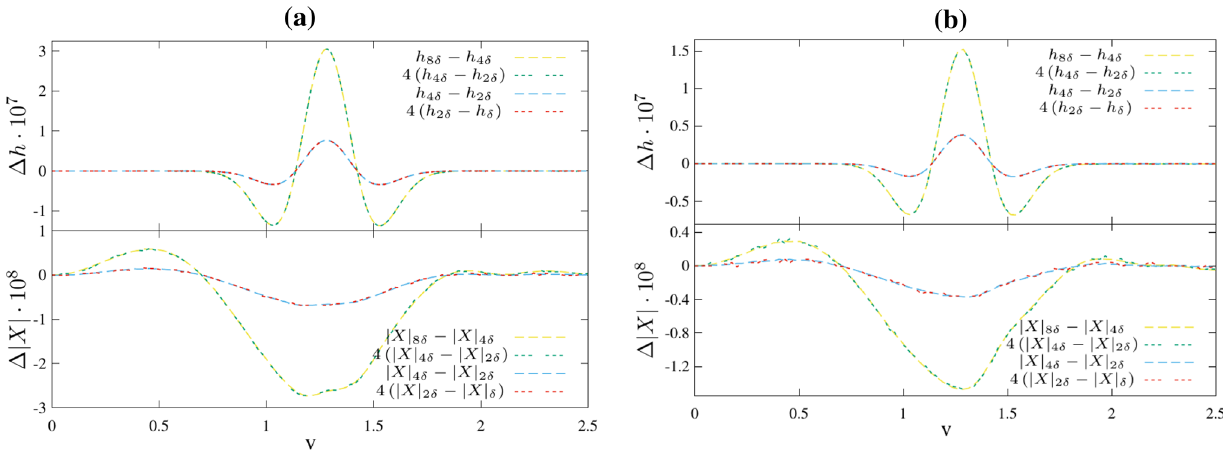
Fig. 20 The convergence of the code. The differences between the scalar field functions, (cid:18) h , and the moduli of complex scalar field, (cid:18) | X | , calculated on grids with different integration steps (multiples